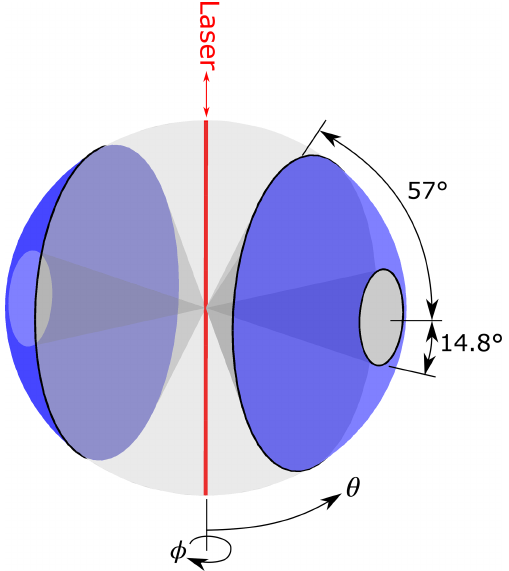
Figure 1. Scattering angles detected by the UHSAS. Mangin mir- rors on opposite sides of the laser focus scattered light on the detec- tors from annular regions perpendicular to the beam between 14.8 and 57 ◦ (shown as the blue surface). The Mie and multiple sphere T -matrix (MSTM) routines calculate scattering integrated over an- gles θ (away from the beam) and φ (relative to the laser polariza- tion) and integrate over the sensing